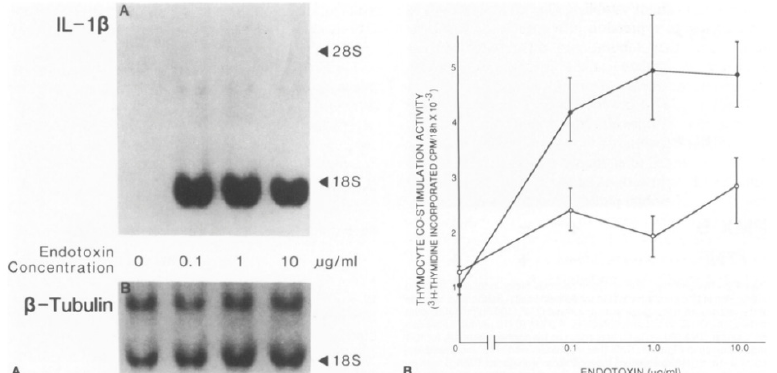
Figure 1. Vascular cells can produce IL-1. ( A ). This Northern blot shows induction of the messenger RNA encoding interleukin-1 β by Gram-negative bacterial endotoxin. The top panel shows IL-1 β transcript. The bottom panel shows β -Tubulin expression in a re-hybridization of the same blot. The left-hand panel ( B ) shows interleukin-1 activity as measured by thymocyte co-stimulation. The supernatants of the cultures of the cells probed for messenger RNA in the left-hand panel were analyzed for biological activity showing the induction of release of activity with incubation with endotoxin. Addition of polymyxin B, an LPS inhibitor, to the medium during exposure to LPS blunted the rise in thymocyte co-stimulatory activity. (open circles). From Am J Path. Libby et al. 1986, 124:179-185